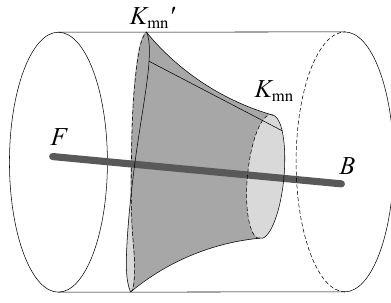
Figure 6. Spot trajectory formed by laser beams.